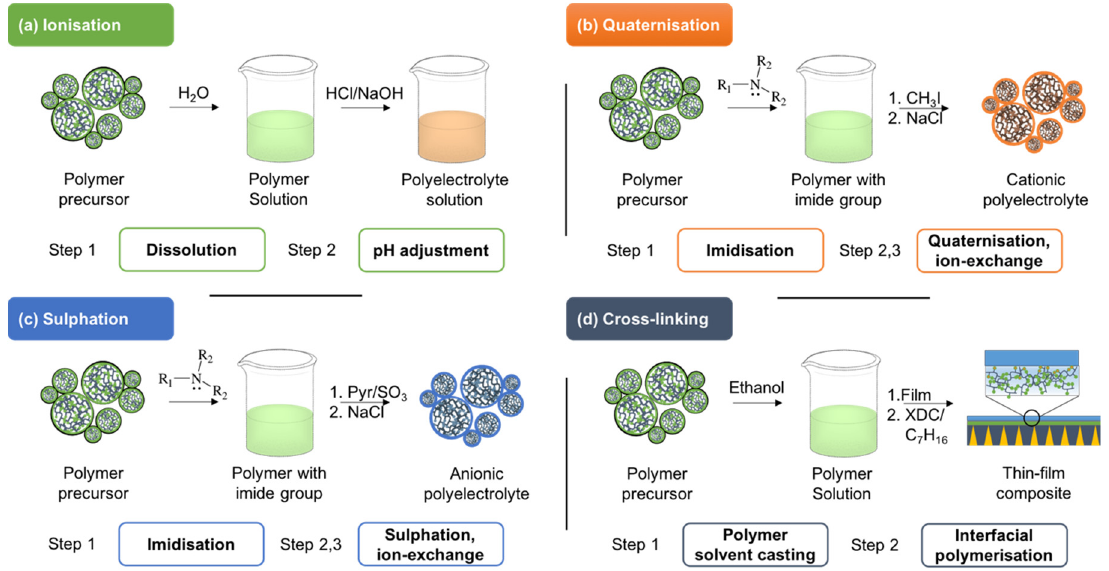
Figure 6. Major approaches for post-synthetic modification of polymers to produce ‘top-down’ polyelectrolytes include ( a ) ionization, ( b ) quaternization, ( c ) sulphation, and ( d ) cross-linking. XDC abbreviates p-Xylylene dichloride.